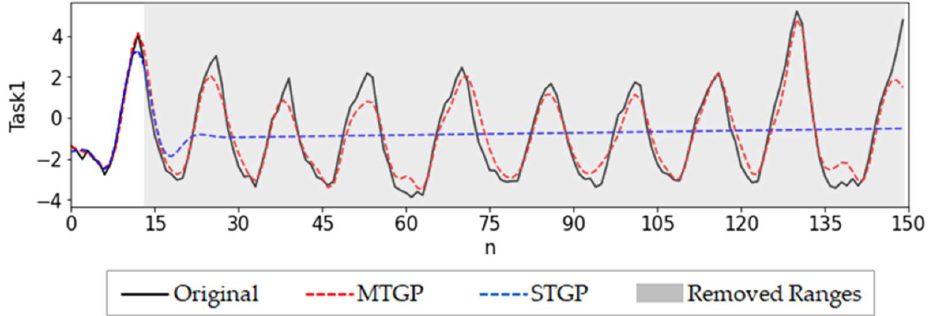
Figure 7. Imputation results of MTGP and STGP for S3. Table 3. Error results of STGP and MTGP for